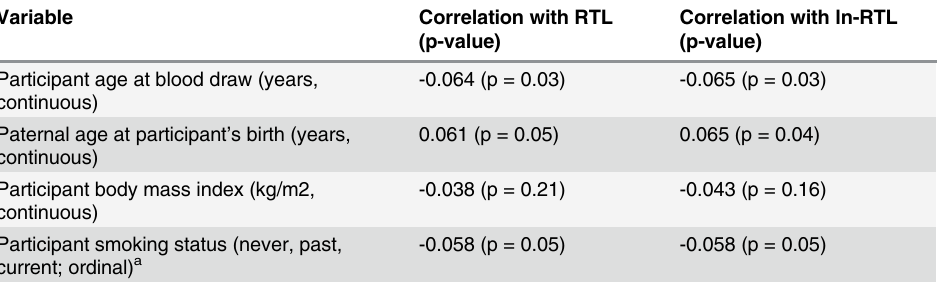
Table 2. Correlations between established telomere length predictors and measured relative telomere length in the study sample. Variable